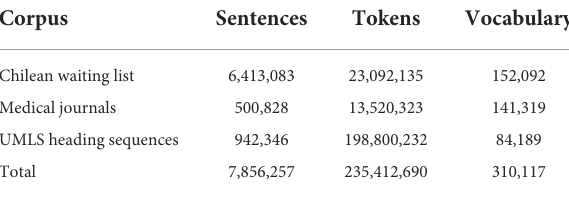
TABLE 1 Corpora descriptive